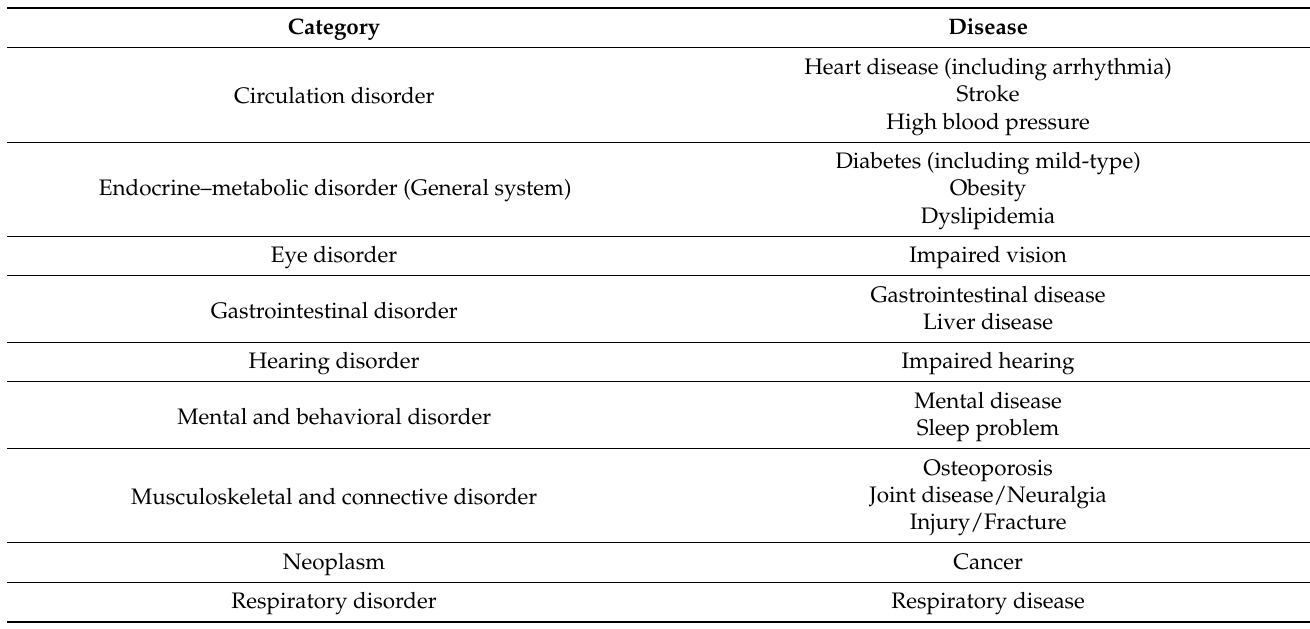
Table 1. Definition of CMM a